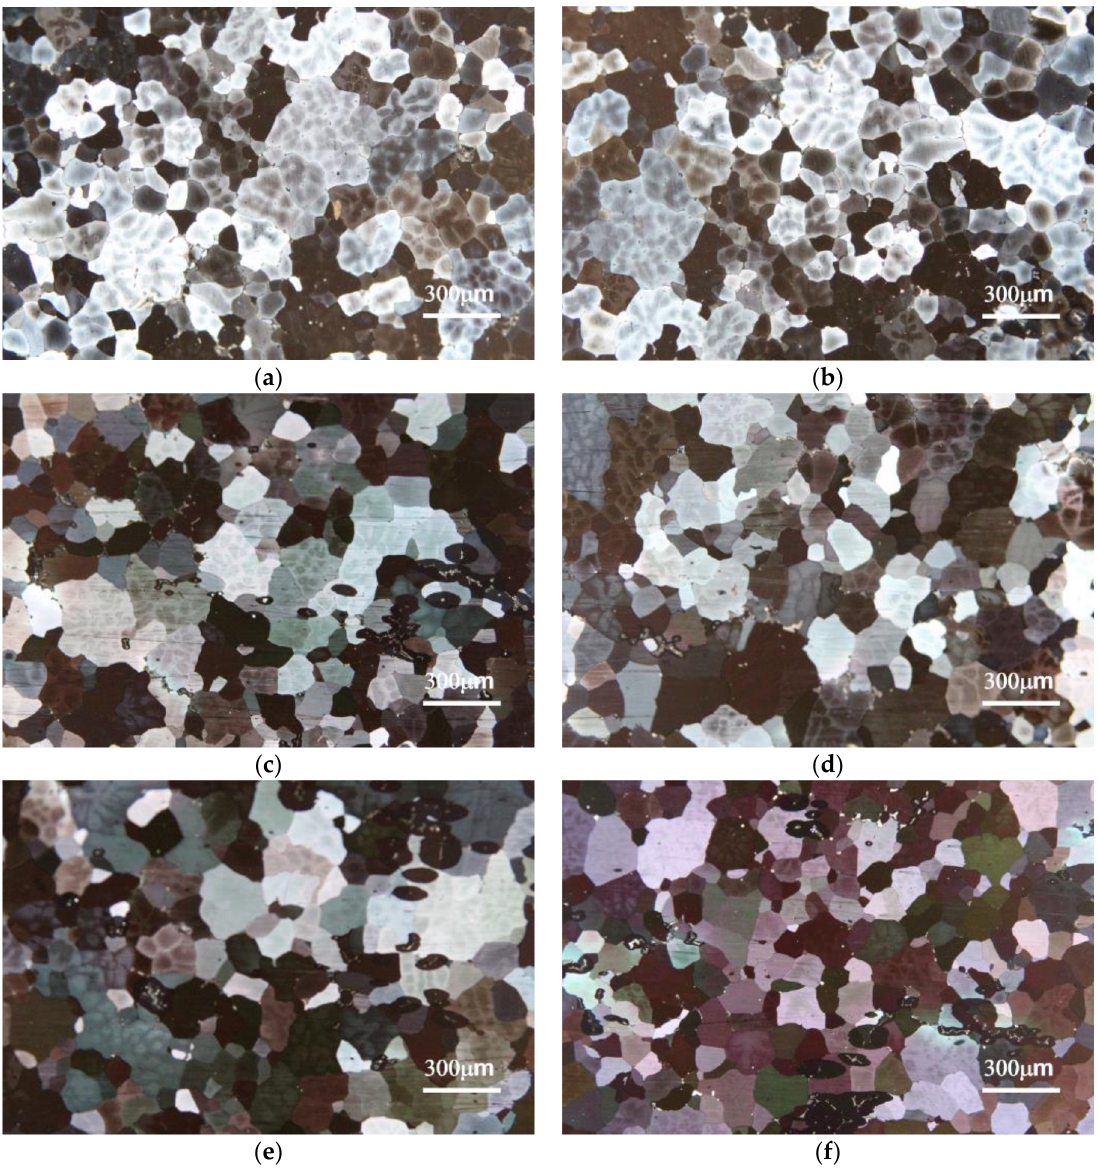
Figure 2. The optical microscope images of ( a ) as-cast alloy A(0.1Zr); ( b ) as-cast alloy B(0.05Sc); ( c ) 1-Hom. alloy A(0.1Zr); ( d ) 1-Hom. alloy B(0.05Sc); ( e ) 2-Hom. alloy A(0.1Zr); ( f ) 2-Hom. alloy